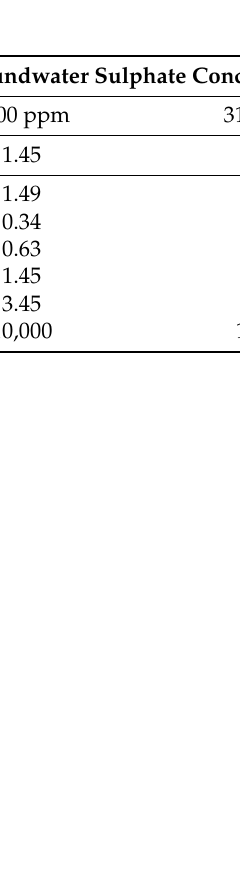
Figure 3. Histogram of UFC lifetimes under scenario A.